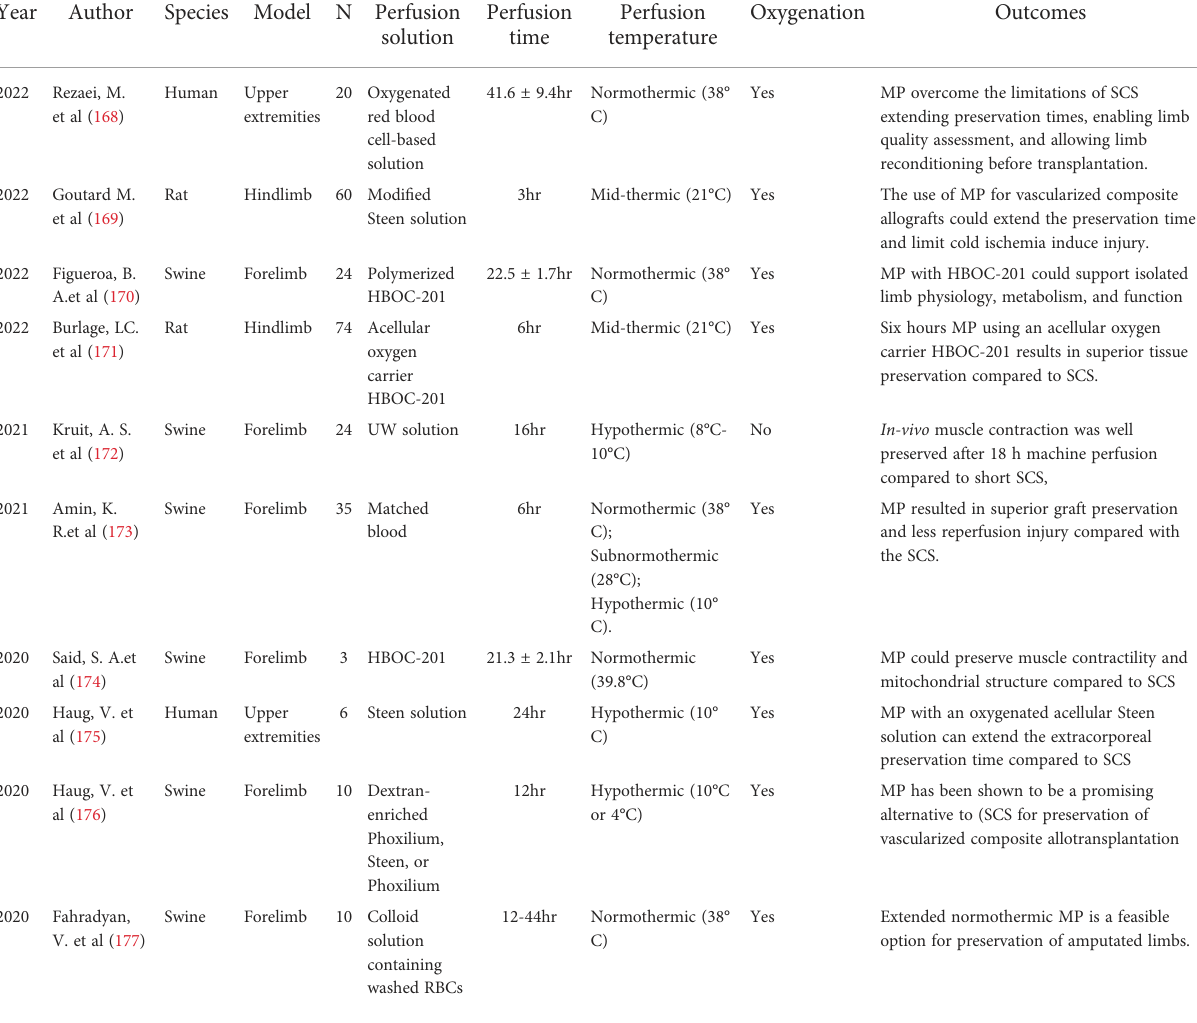
TABLE 4 Machine perfusion in